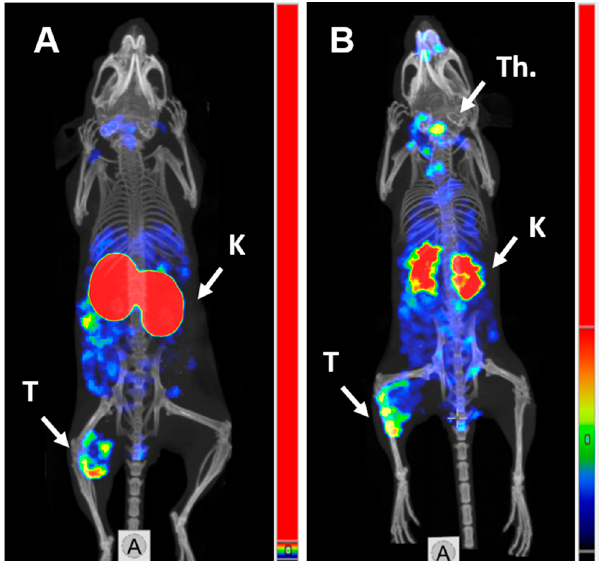
Figure 4. MicroSPECT/CT imaging of HER3 expression in BxPC3 xenografts in Balb/c nu/nu mice using ( A ) [ 111 In]In-(HE) 3 -Z HER3:08698 -DOTAGA and ( B ) [ 125 I]I-PIB-(HE) 3 -Z HER3:08698 -DOTAGA 4 h pi. K—kidneys; T—tumor; Th.—thyroid.